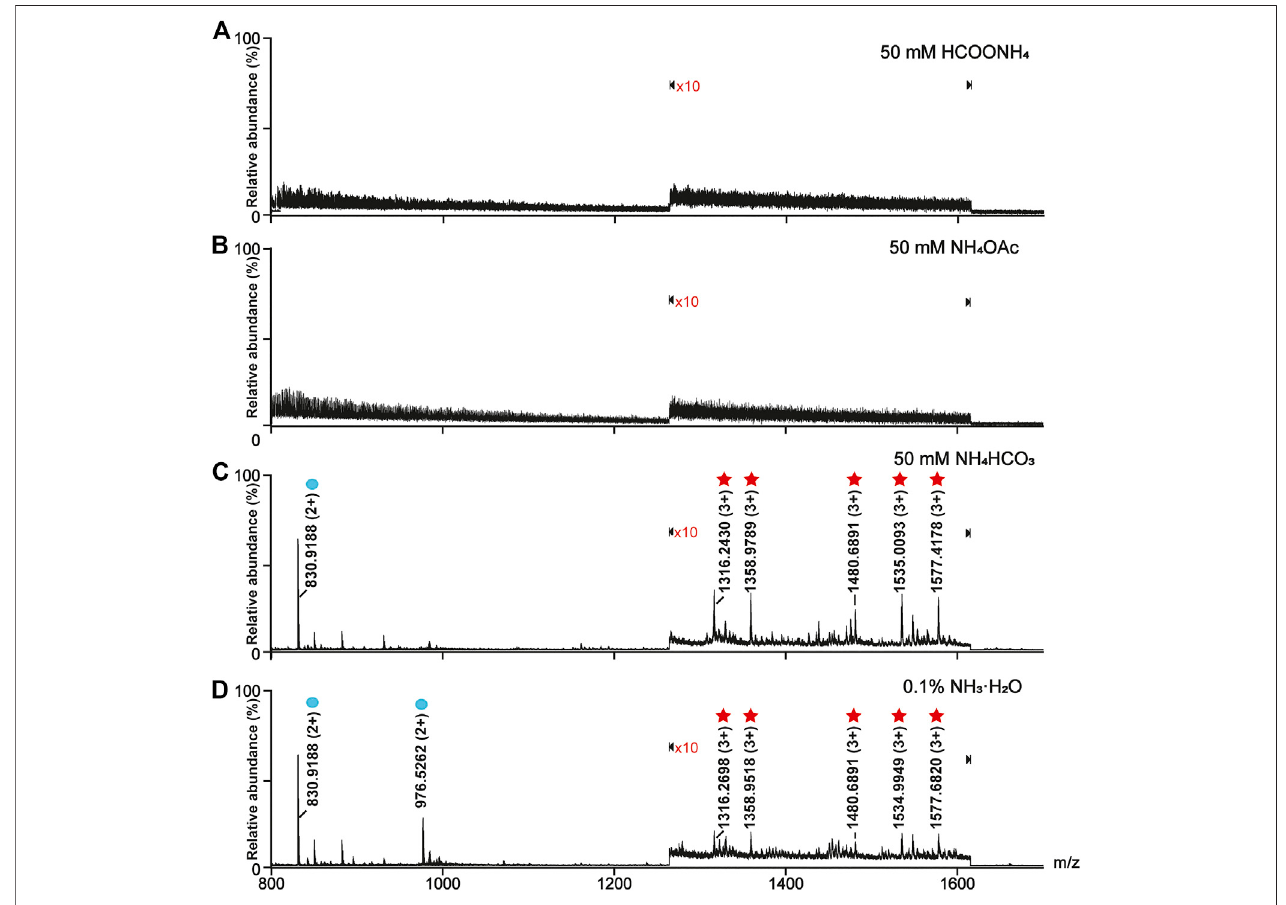
FIGURE 1 | Optimization of the online deglycosylation condition in different solution pH. (A) 50 mM HCOONH 4 (pH 4.6), (B) 50 mM NH 4 OAc (pH 6.9), (C) 50 mM NH 4 HCO 3 (pH 8.3), and (D) 0.1% (v/v) NH 3 · H 2 O (pH 11.5). The glycopeptides and phosphopeptides were marked with red stars and blue circles, respectively. The signals at m/z ranging from 1,265 to 1,615 in the mass spectra were ampli fi ed tenfold ( × 10), where “ × 10 ” represents the magni fi cation times.